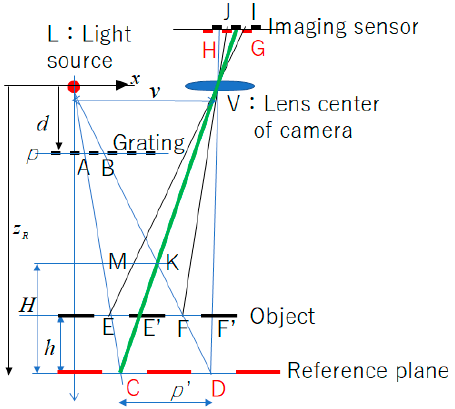
Figure 3. Schematic optical system for explanation [17].